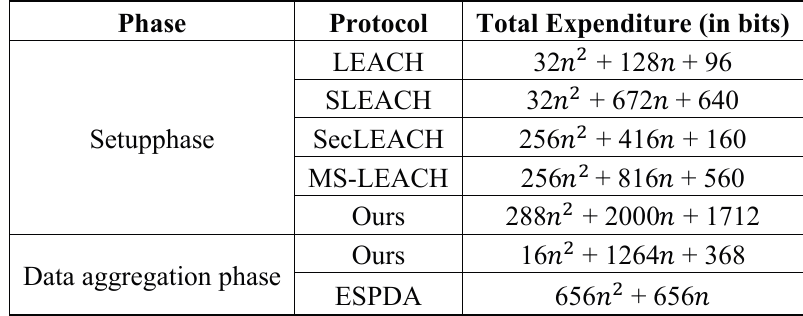
Table 14. Comparison of intra-cluster radio transmission